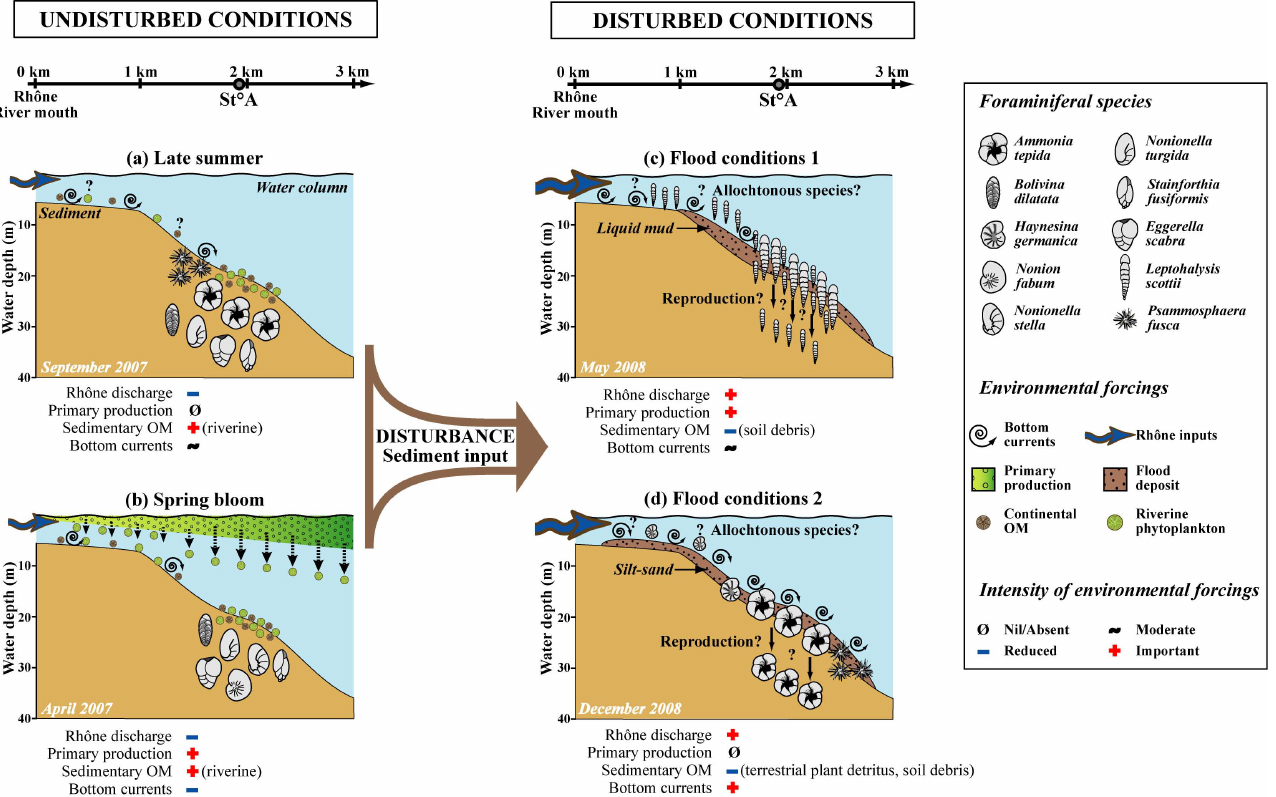
Fig. 12. Synthetic picture of the processes influencing the foraminiferal faunal composition during the four investigated periods at the shallowest Station